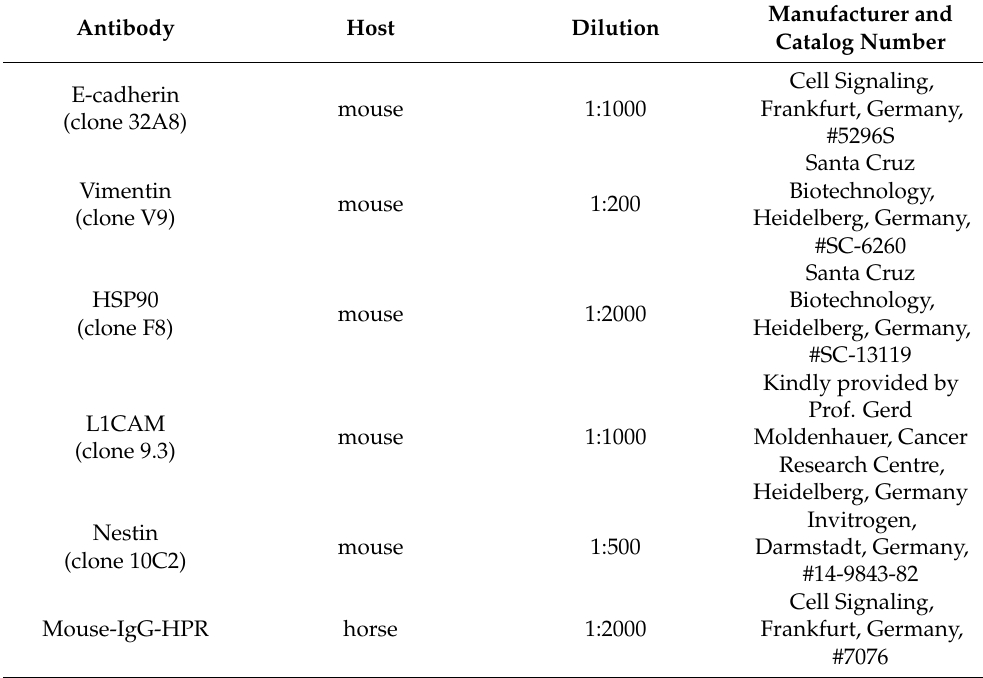
Table 1. Antibodies used for Western